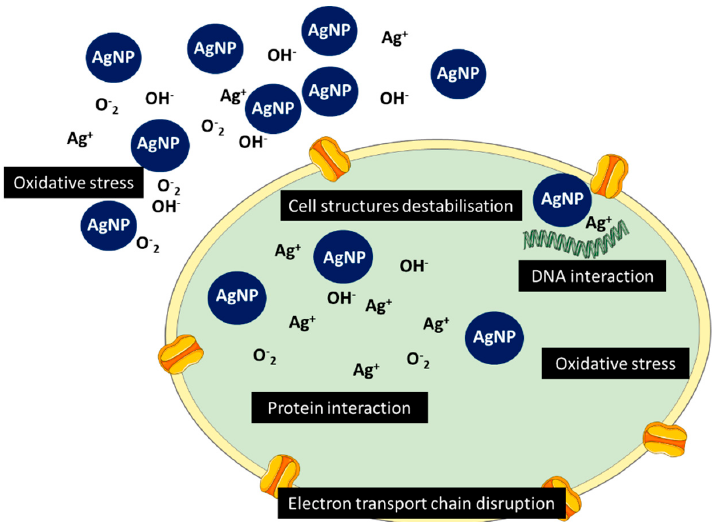
Figure 5. Schematic representation of AgNPs mechanism of antimicrobial activity.